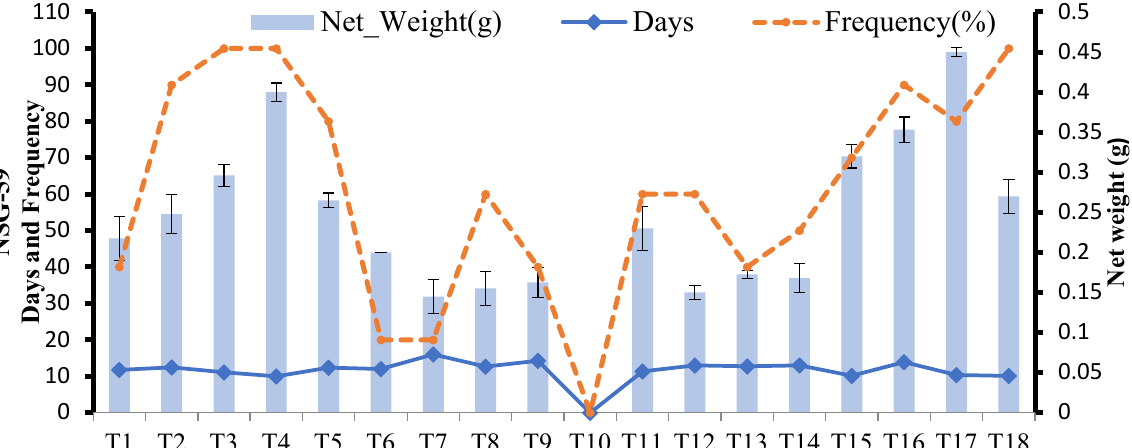
Figure 5. Effect of different media compositions on callus induction in terms of callus, number of days, and frequency in NSG-59.